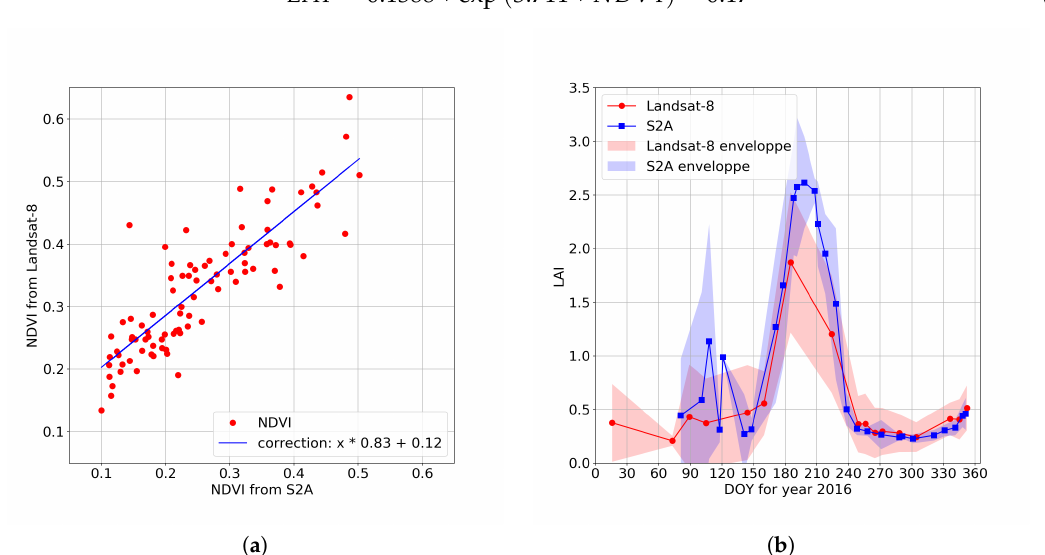
Figure 2. Homogenization of Sentinel-2A and Landsat-8 data using an empirical exponential model. Normalized Difference Vegetation Index (NDVI) correction ( a ) and final leaf area index (LAI) time series ( b ).